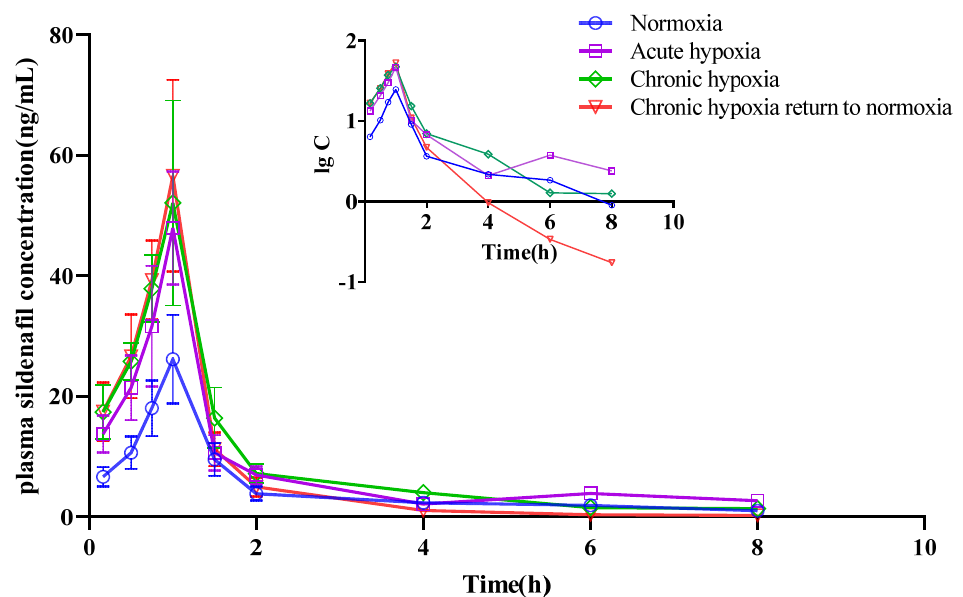
Figure 6. Mean plasma concentration time curve of sildenafil for rats after exposure to high-altitude hypoxia ( n = 8).